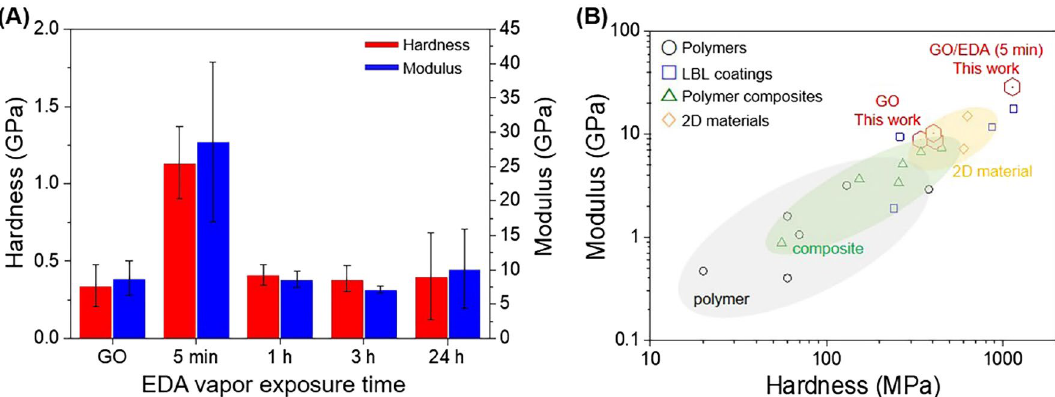
Figure 5. ( A ) The hardness and modulus of GO/EDA coatings measured by the nanoindentation technique and the average values were obtained from 3 to 5 points for each sample. ( B ) Mechanical properties comparison between GO/EDA coating and various coating